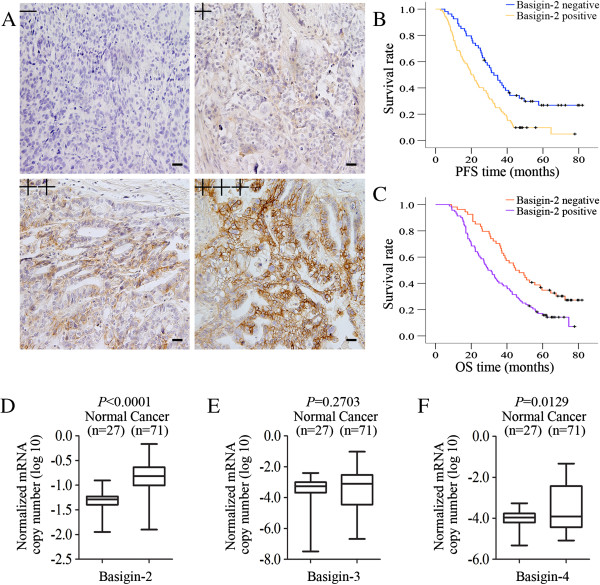
Basigin-2 expression level and its prognostic effects in epithelial ovarian cancer. A Representative images of Basigin-2 protein expression in paraffin-embedded tissue from 146 patients with epithelial ovarian cancer (−, +, ++, +++). Scale bars = 0.1 mm. B The progression-free survival curves for the high-basigin-2 expression group (n = 92) and the low-basigin-2 expression group (n = 54). The progression-free survival rates between the two groups showed significantly different (P < 0.001). C The overall survival curves for the high-basigin-2 expression group (n = 92) and the low-basigin-2 expression group (n = 54). The overall survival rates between the two groups showed significantly different (P = 0.001). D-F Overexpression of basigin variants in epithelial ovarian cancer tissues. The expression levels of basigin variants were calculated as the log10 value of the normalized ratio.